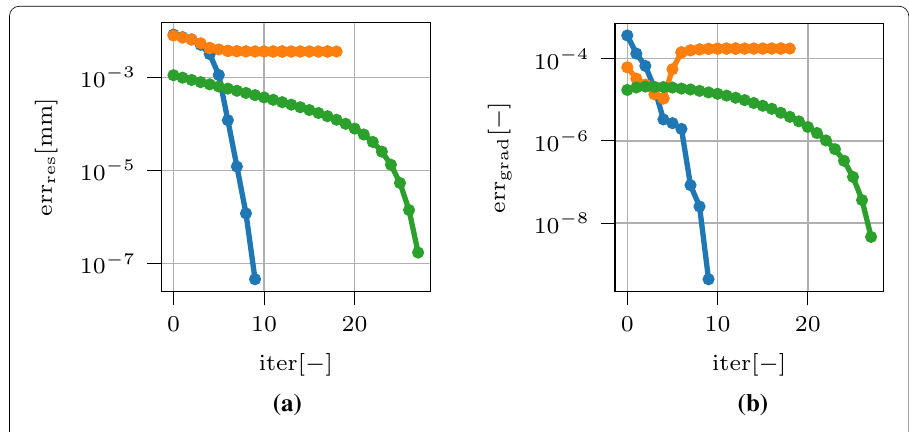
Fig. 18 Result of inverse analysis for porous setting a residual error err res b gradient based error err grad over